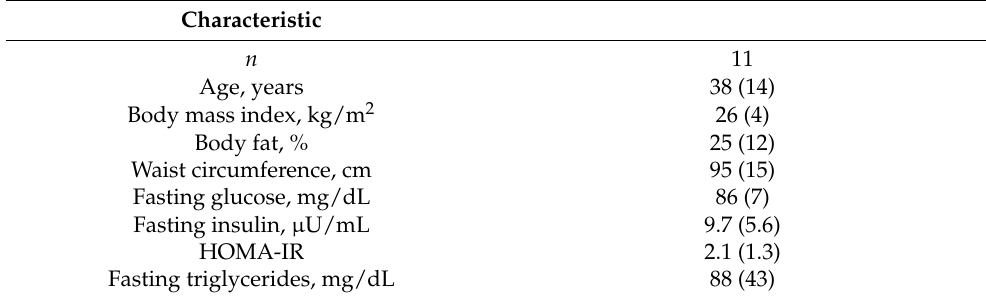
Table 1. Baseline characteristics of healthy men before Bah á ’ í fasting 1